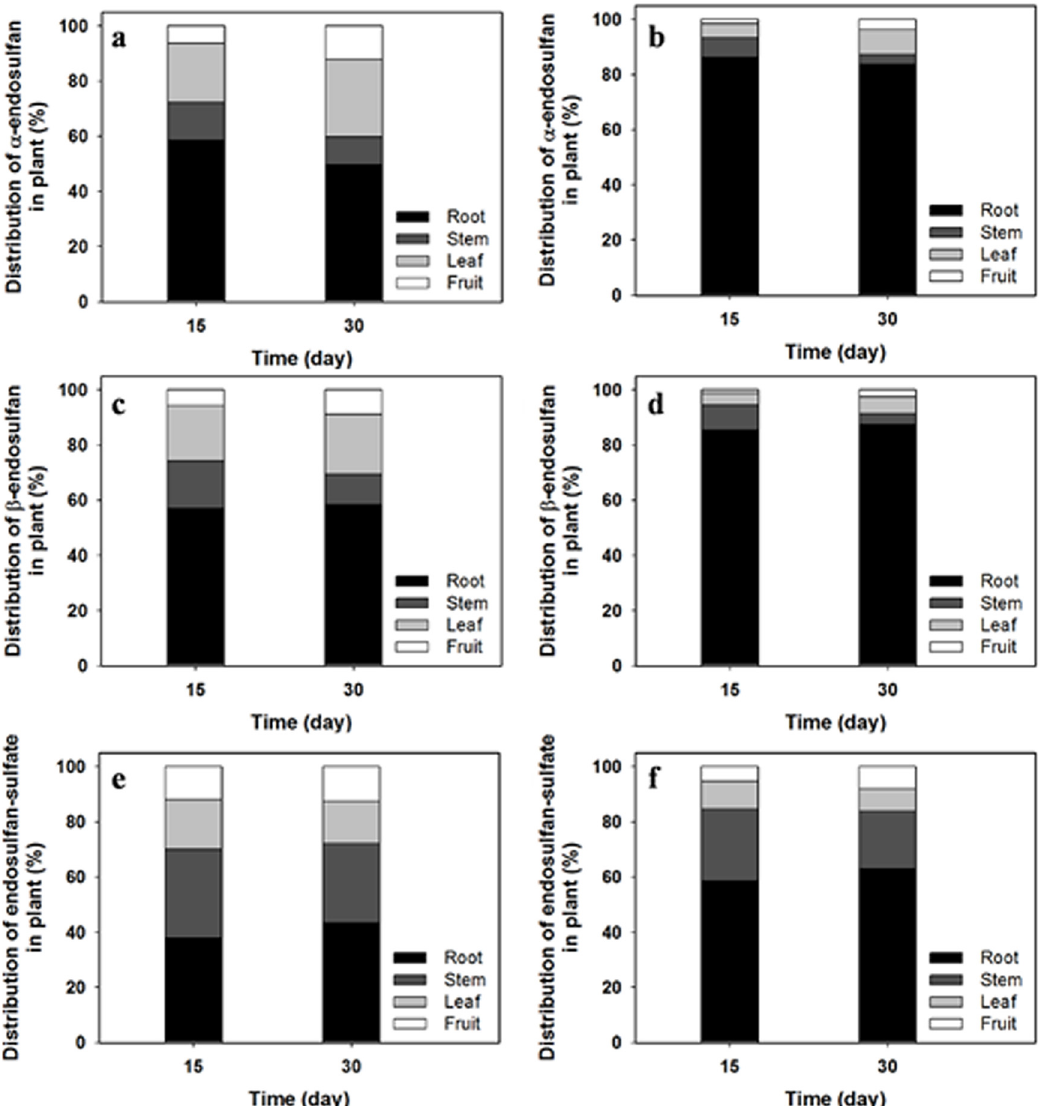
Fig 2. Time-dependent distribution of α - (a, b) and β -isomers of ED (c, d), as well as its sulfate-metabolite (e, f), in each cucumber compartment under treatment concentrations of 20 mg kg -1 (a, c, e) and 40 mg kg -1 (b, d, f) as observed in the indoor test.